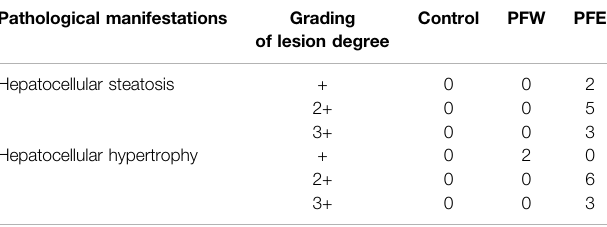
TABLE 1 | Pathological manifestations of PFW and PFE in mice. Pathological manifestations